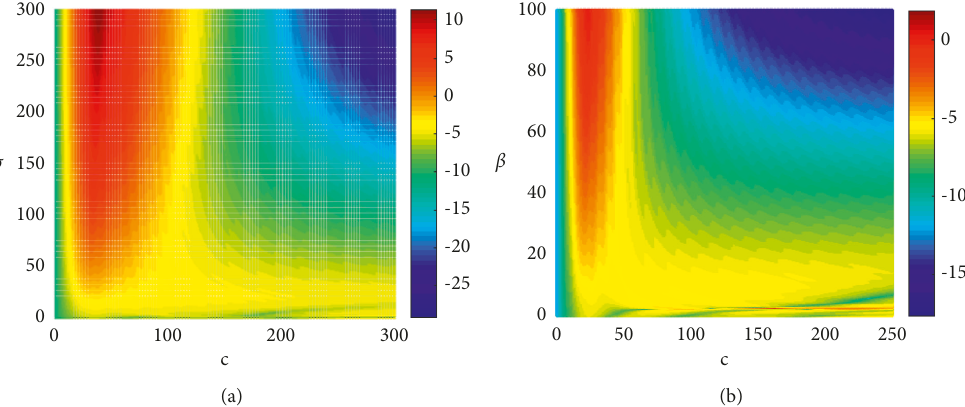
Figure 2: 2-D bifurcation diagrams showing the dynamics of system (4a–4c) by varying two different parameters simultaneously. The right column bar represents the value of the MLE. (a) σ and c; (b) β ; and (c) the rest of the parameters of the systems are (a) u � 0.009; β � 0.03; v � 0.005; and T 3 � 0.01; (b) u � 0.009; sigma � 2.65; v � 0.005; and T � 0.01; the initial conditions are x � 0.01; y � 0.01; and z � 3